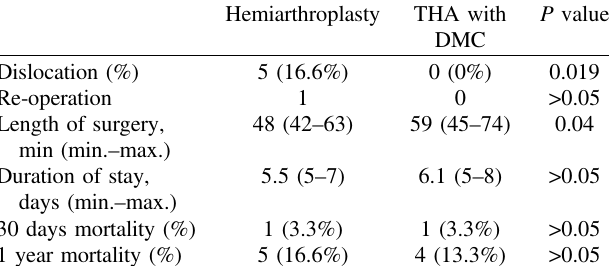
Table 2. Primary and secondary outcomes.